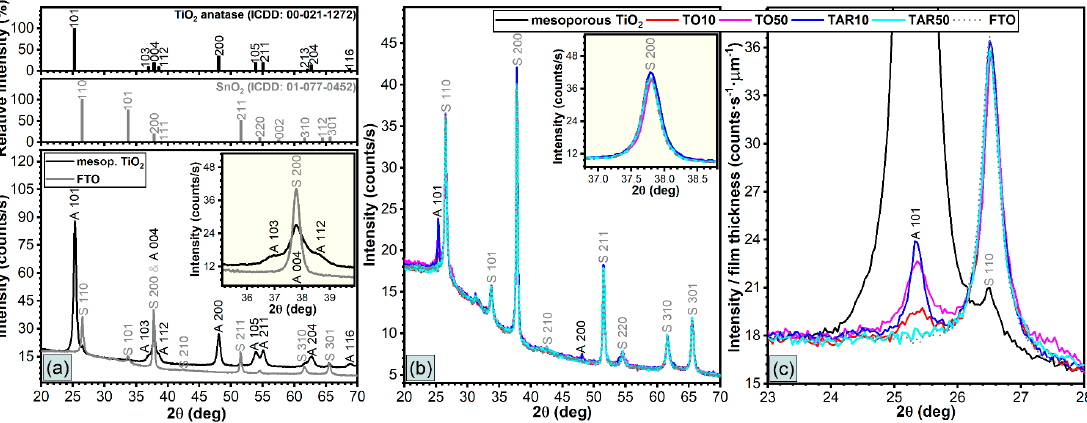
Figure 3. XRD patterns of the TiO 2 mesoporous film and of the TiO 2 buffer layers deposited by PLD on FTO glass substrates: TiO 2 mesoporous film vs. FTO substrate ( a ); PLD layers vs. FTO substrate ( b ) and detail of the XRD pattern characteristic to the anatase (101) peak ( c ).